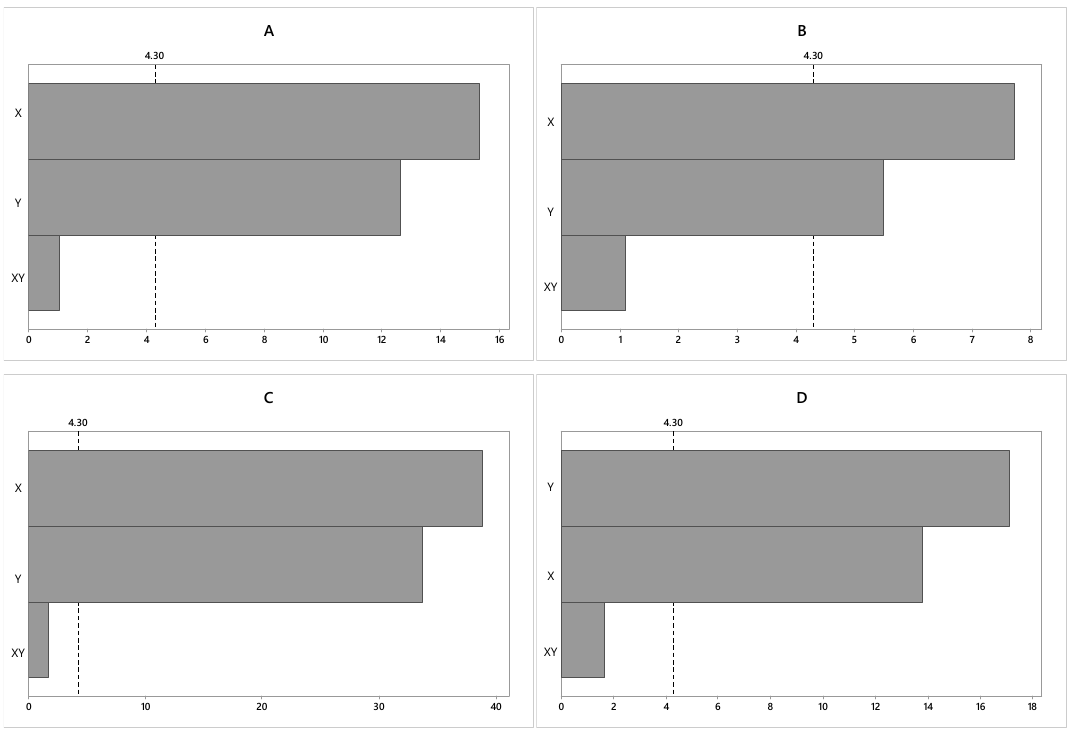
Figure 2. Effect of the independent variables (X: Light intensity and Y: NaNO 3 concentration) and their interaction (XY) on biomass productivity (mg/L/day) for a 95% confidence level. ( A ) Synechocystis sp. CACIAM05; ( B ) Microcystis aeruginosa CACIAM08; ( C ) Pantanalinema rosaneae CACIAM18; ( D ) Limnothrix sp. CACIAM25.